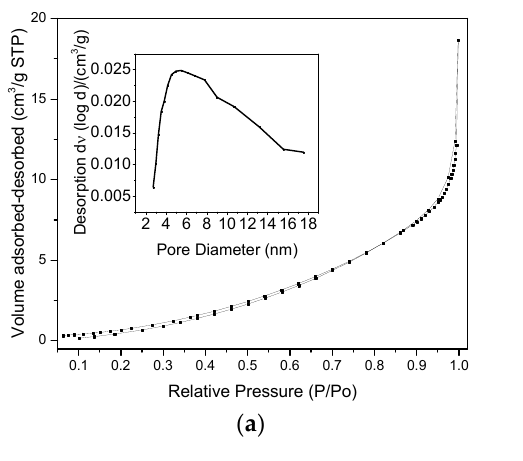
Figure 6. Nitrogen adsorption-desorption isotherms and the corresponding pore size distribution curves (inset): ( a ) ZnO N ; ( b ) ZnO A .